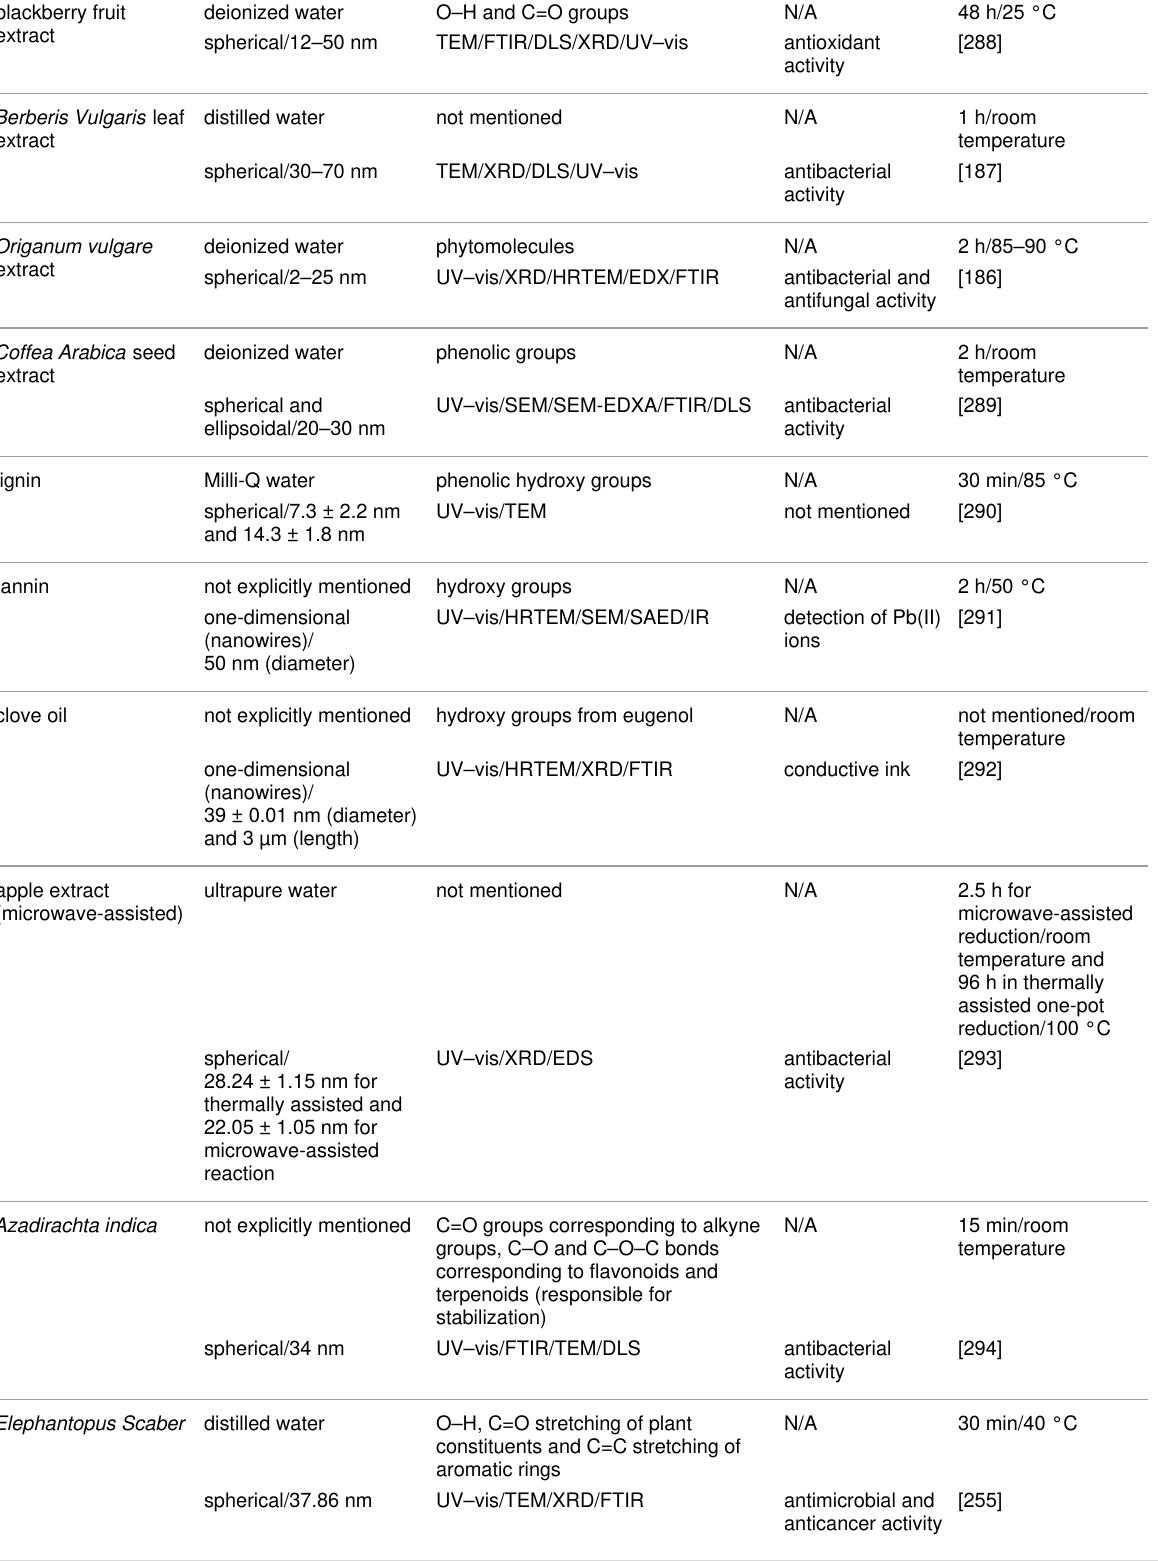
Table 2: A review of various green processes, reaction conditions, necessary functional groups, and characterization techniques used for the synthe- sis of silver nanostructures with different sizes and morphologies along with their application. (continued) blackberry fruit extract